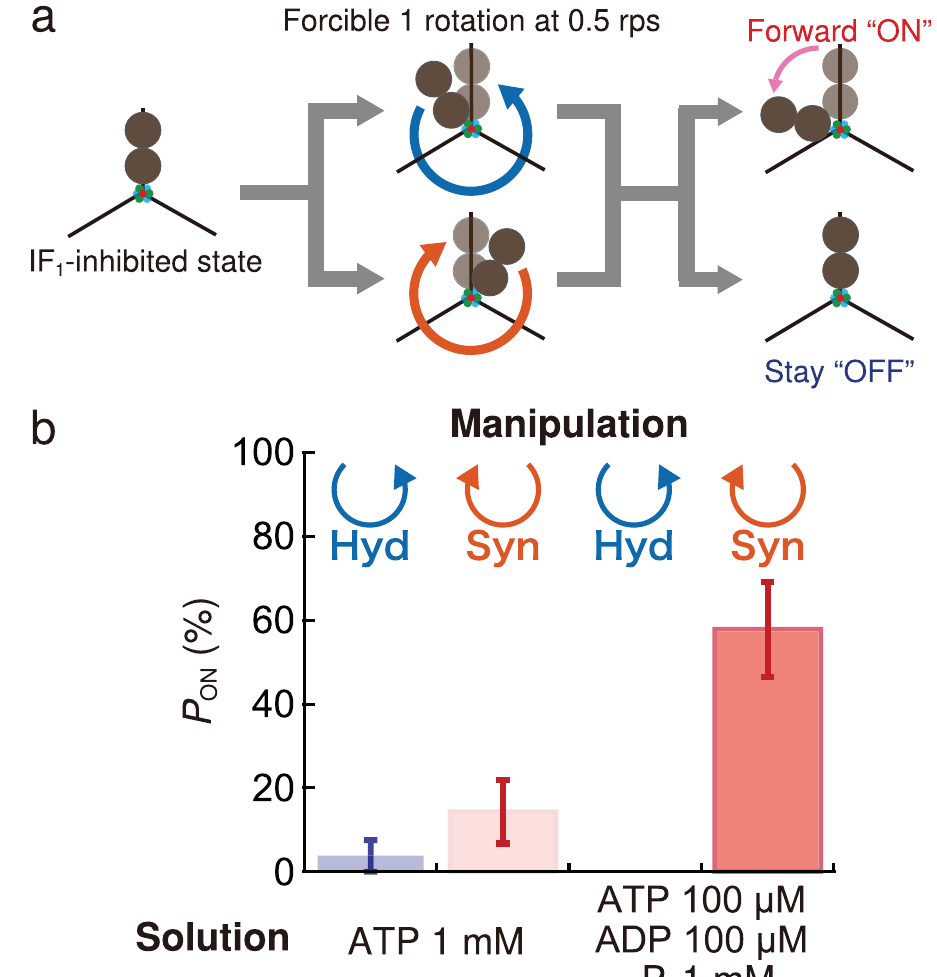
Fig. 3 | Single-molecule manipulation ofIF 1 -inhibited b MF 1 . a Schematicimages of the manipulation procedure. When b MF 1 was stalled by IF 1 , the magnetic twee- zers were turned on to stall b MF 1 to rotate one clockwise or counterclockwise revolution at the rate of 0.5 revolutions per second (rps). After manipulation, released b MF 1 either resumed its rotation (ON) or did not (OFF). These behaviors indicate whether or not IF 1 dissociates from b MF 1 under the stalling time. b ReactivationprobabilityofIF 1 -inhibited b MF 1 aftermanipulation. “ Hyd ” and “ Syn ”